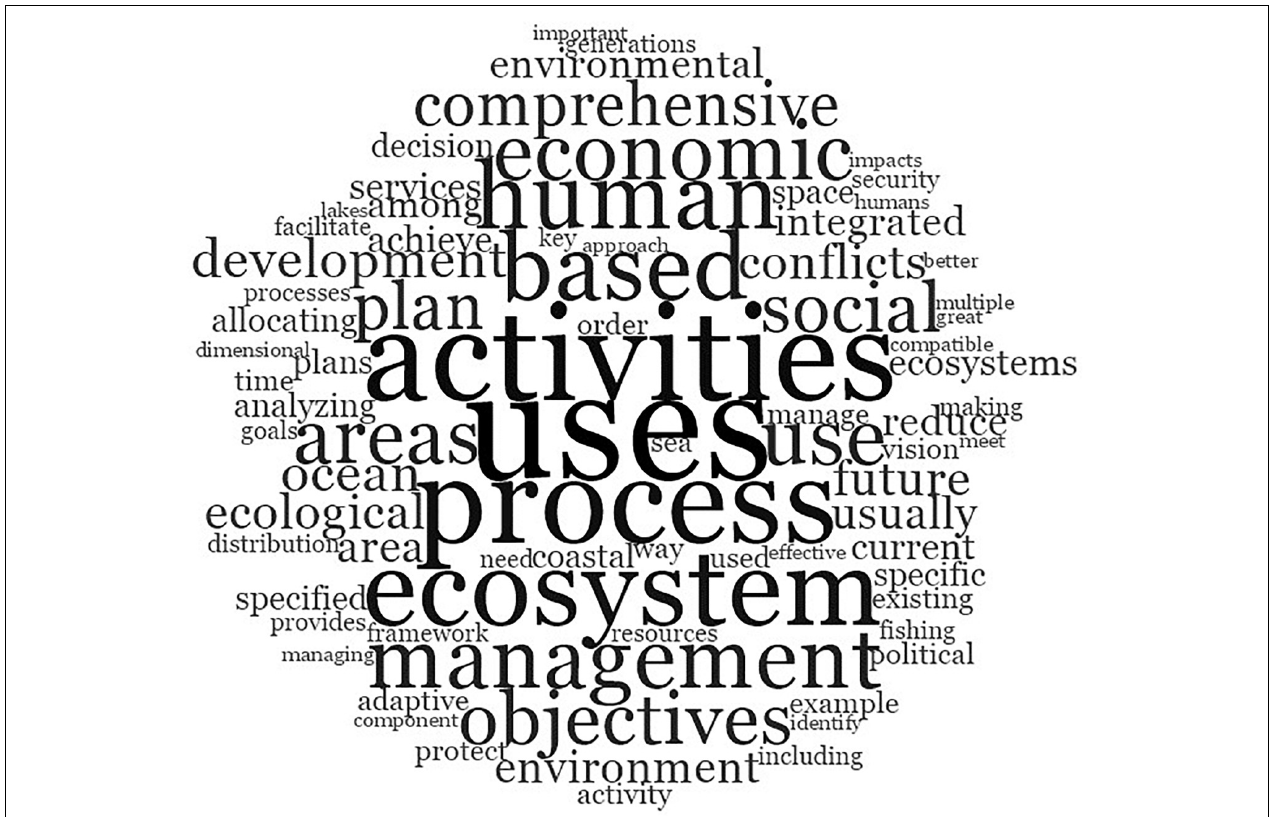
FIGURE 2 | Word cloud generated by Nvivo based on the definitions of MSP found in the 30 defining documents. The words “marine,” “spatial,” and “planning” were excluded from the word frequency analysis to not influence results. The size of each word represents the percentage of all citations relative to the other words. Baseline data can be found in Supplementary Material C .